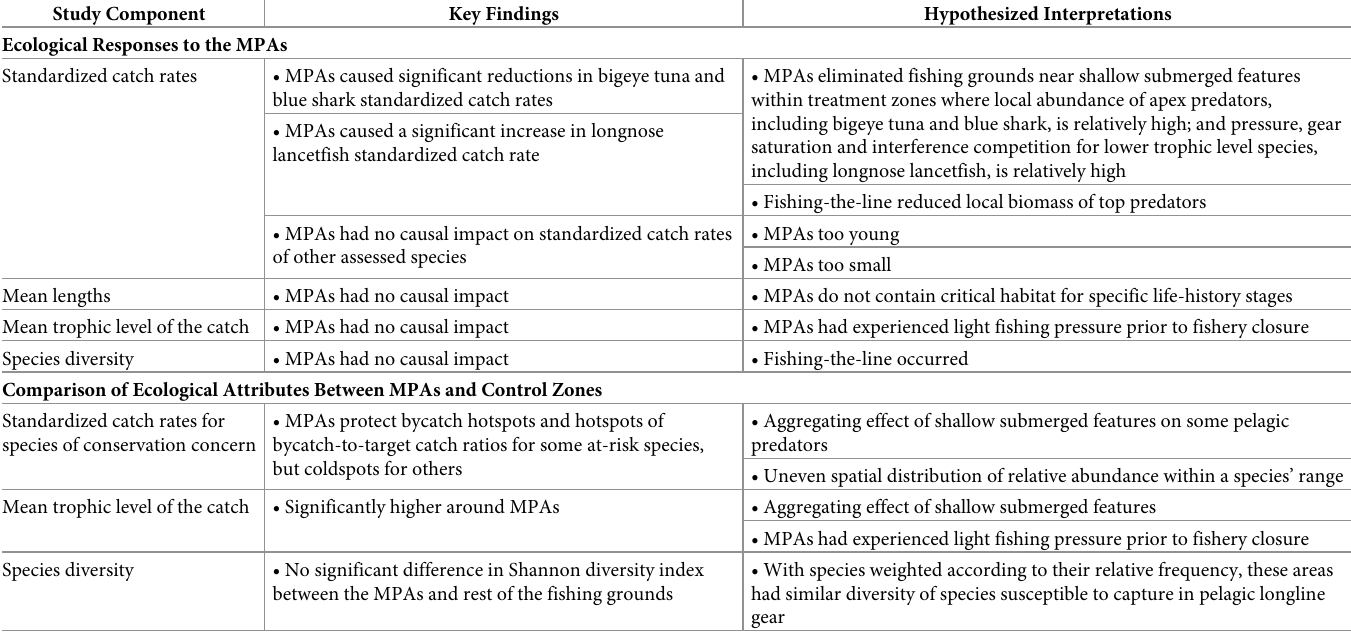
Table 2. Summary of key findings and